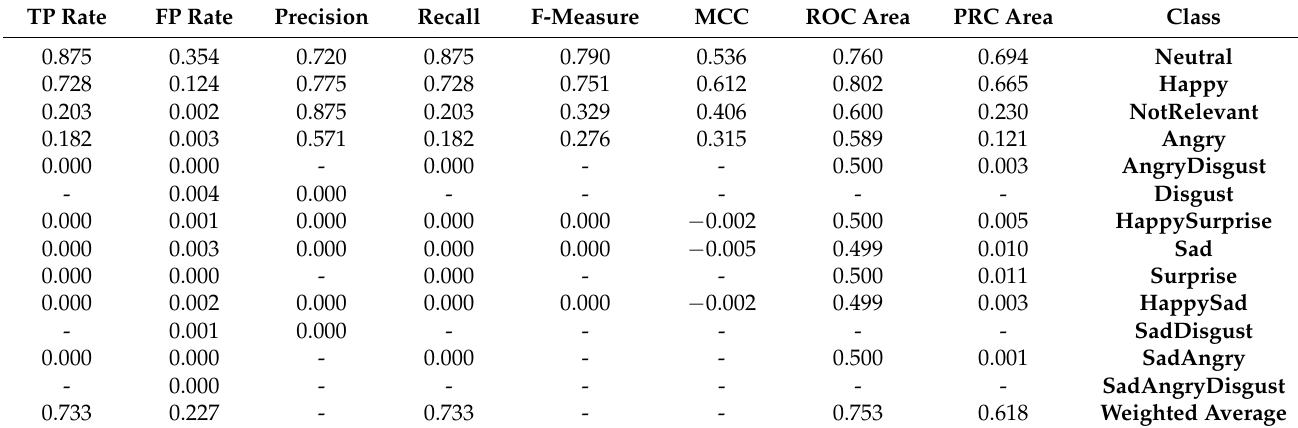
Table 4. Detailed accuracy by class (single feature selection technique).